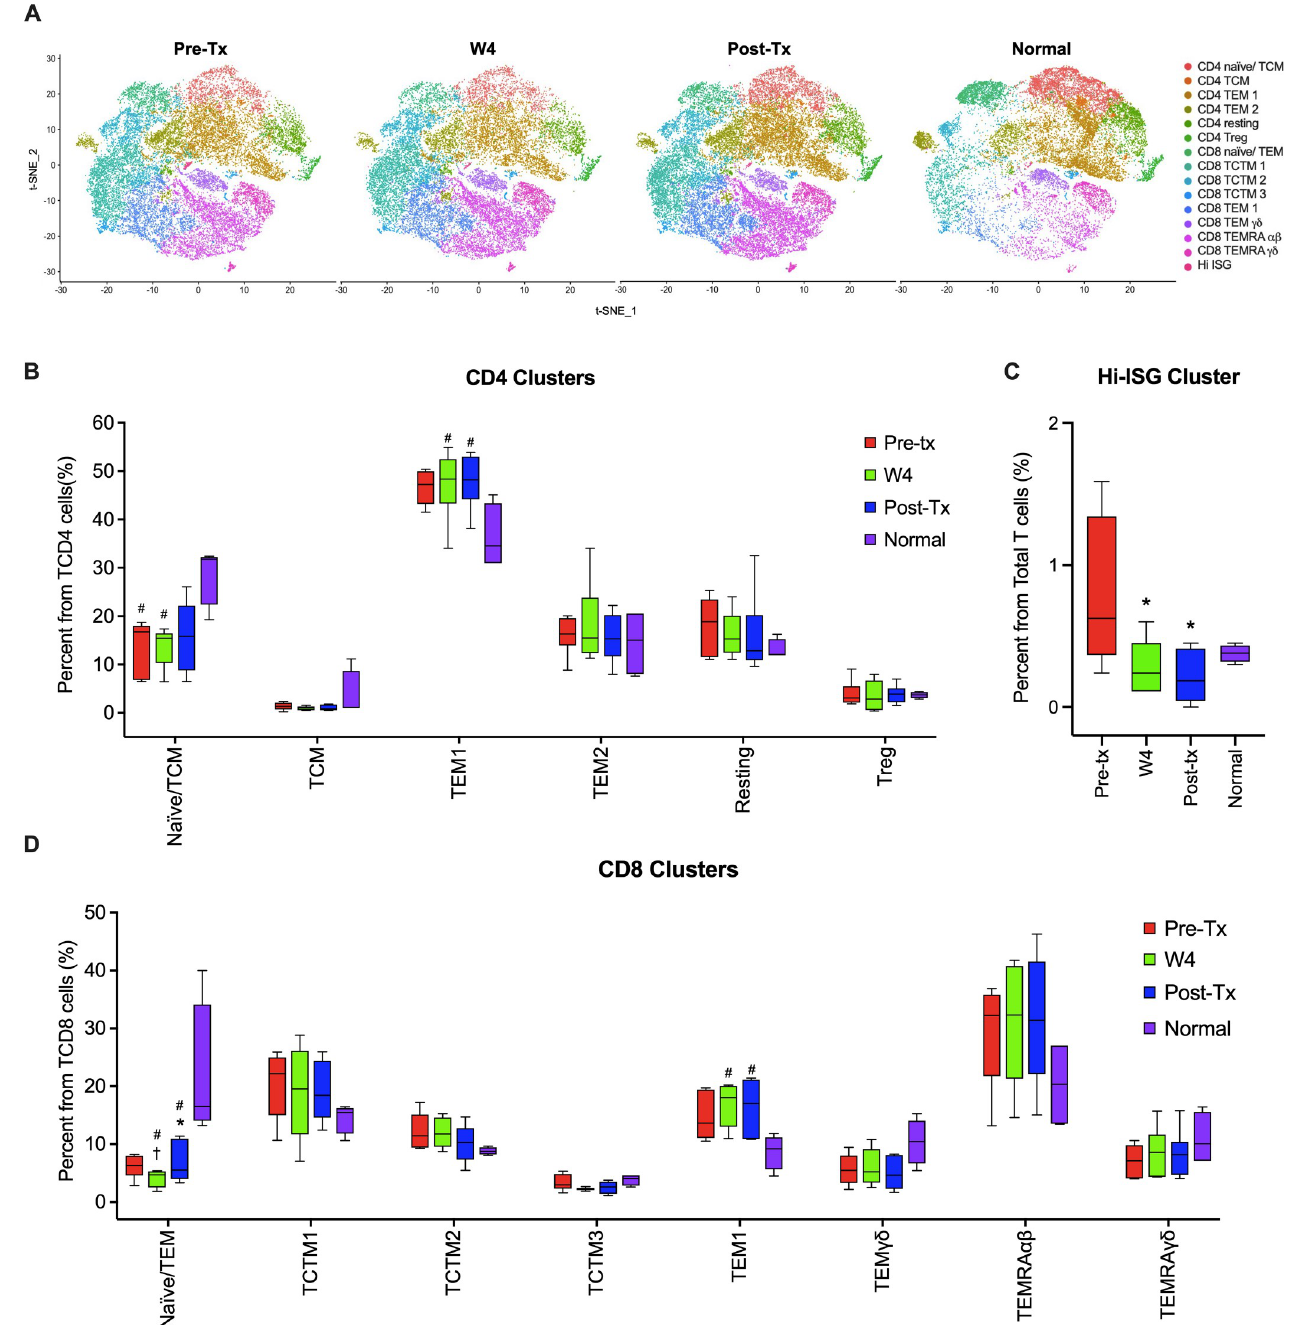
Fig 1. Overall distribution of peripheral blood T cell populations. ( A ) Clustering revealed 15 distinct T cell populations represented here in two-dimensional space using t-Distributed Stochastic Neighbor Emending (tSNE). All cells from each patient (n = 6) and time points are plotted, including cells from normal healthy controls (n = 3). Global changes in T cell subpopulations frequencies were analyzed during DAA therapy and compared to healthy controls. ( B ) The frequencies of the six CD4 clusters during and after DAA therapy and those found in normal control subjects is shown. ( C ) The frequency of the Hi-ISG cluster decreased to normal levels during and after therapy in HCV patients when compared to the samples before starting DAA treatment. ( D ) The frequencies of the eight CD8 clusters during and after DAA therapy and those found in normal control subjects is shown. Differences among time points within a cluster were tested using Friedman’s One-Way ANOVA for the HCV paired samples, and Kruskal-Wallis to compare HCV samples to healthy controls. � Significant compared to Pre-Tx; † Significant compared to Post-Tx; # Significant compared to Normal. TCM: T central memory; TEM: T effector memory; Treg: T regulatory; TCTM: T central-transitional memory; TEMRA: Terminally Differentiated Effector Memory; Tx: DAA Treatment.